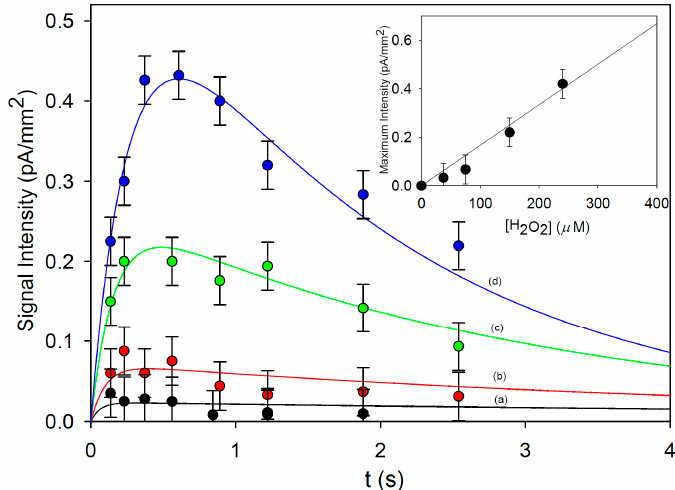
Figure 7. Signal intensity generated by the chemiluminescent decay of 2 * versus residence time in the chip ([ 1 ] = 1.0 mM, [4-IOP] = 0.10 mM, T = 25 °C). The measurements were carried out at four different H 2 O 2 concentrations: 37.5 μ M ( a ), 75 μ M ( b ), 150 μ M ( c ), 240 μ M ( d ). Data points are experimental, and the solid line is the plot of Equation (1) with best fit k 2 = (2.5 ± 0.3) × 10 3 M − 1 s − 1 , k c = 9.0 ± 3.2 s − 1 . Inset: plot of the maximum signal intensity versus the initial concentration of H 2 O 2 . The slope of the calibration curve is (1.67 ± 0.12) 10 − 3 pA mm − 2 μ M − 1 and the limit of detection (LOD) and quantification (LOQ) for H 2 O 2 are 18 and 60 μ M, respectively. These values are comparable to the best performances reported in the literature for chemiluminescent-based optofluidic sensors [20,21,24]. Even though other authors using absorbance [39] or fluorescent [40] detection methods achieved better sensitivities in the detection of hydrogen peroxide, it is important to highlight the following features of our proposed system: a.